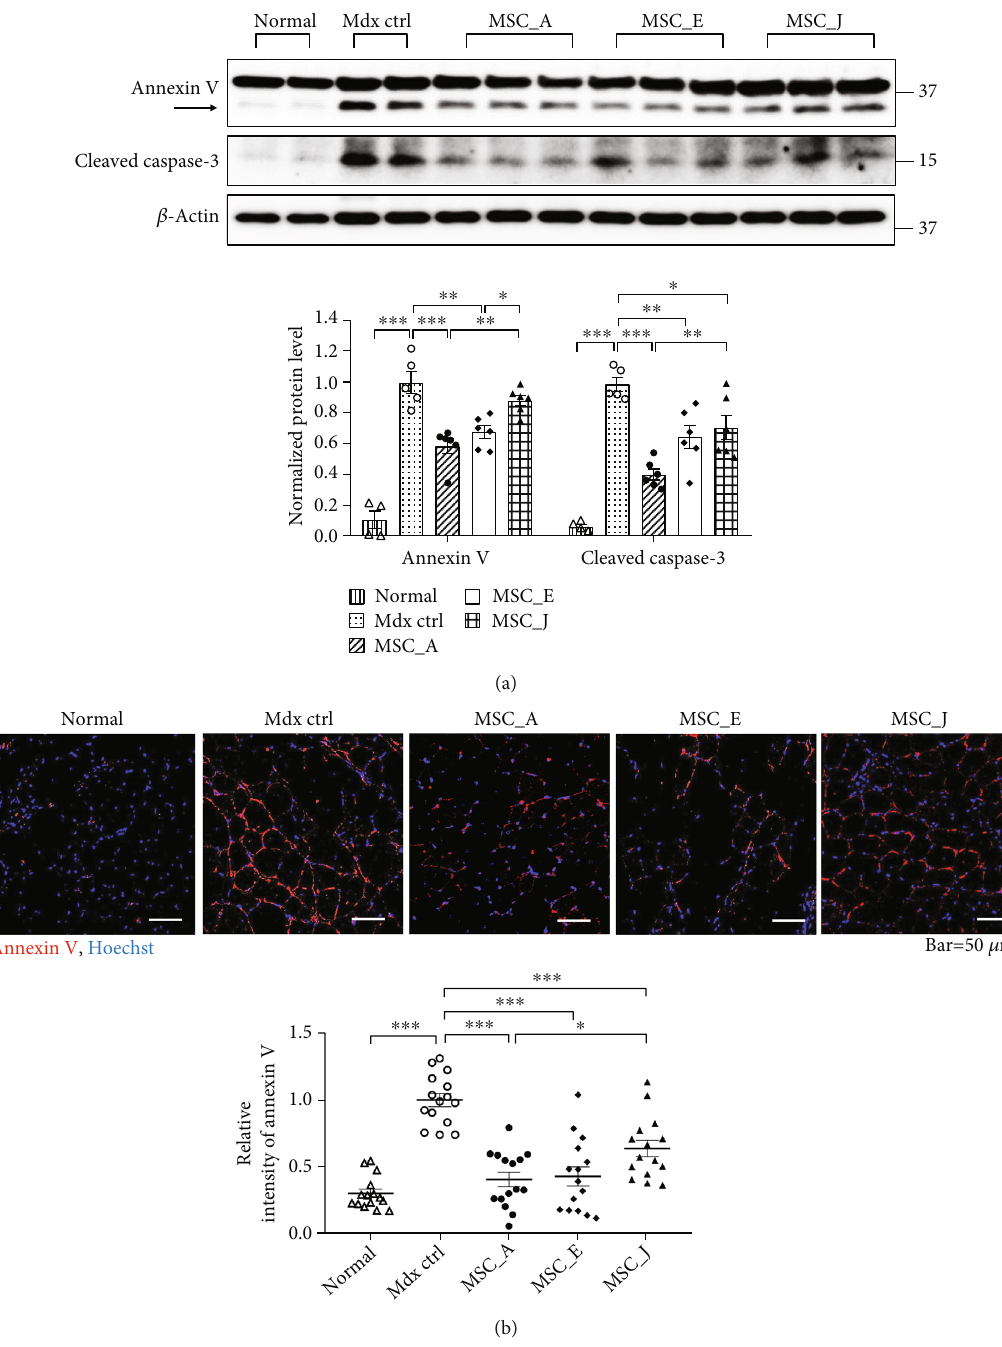
Figure 6: Antiapoptotic e ff ect based on the di ff erences in AURKA mRNA expression of WJ-MSCs in the skeletal muscle of mdx mice. (a) Protein expression levels of annexin V and cleaved caspase-3 were con fi rmed using western blotting. (b) Immunohistochemistry of annexin V was conducted in the gastrocnemius muscles of mdx mice (red, annexin V; blue, Hoechst). Relative intensity of annexin V indicates the value converted based on that of the mdx control group. Data are shown as means ± SEM . One-way ANOVA with Tukey ’ s multiple comparison test (a) and Dunnett ’ s multiple comparison test (b). ∗∗∗ p < 0 : 001 , ∗∗ p < 0 : 01 , and ∗ p < 0 : 05